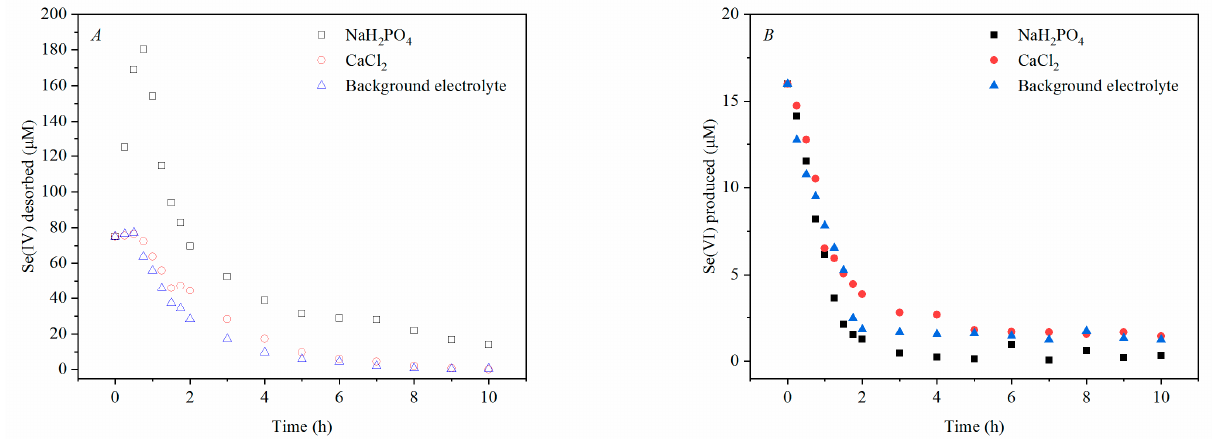
Figure 3. Se(IV) desorbed ( A ) and Se(VI) produced ( B ) by NaH 2 PO 4 , CaCl 2 , and background electrolyte after Se(IV) oxidation by δ -MnO 2 for 24 h.